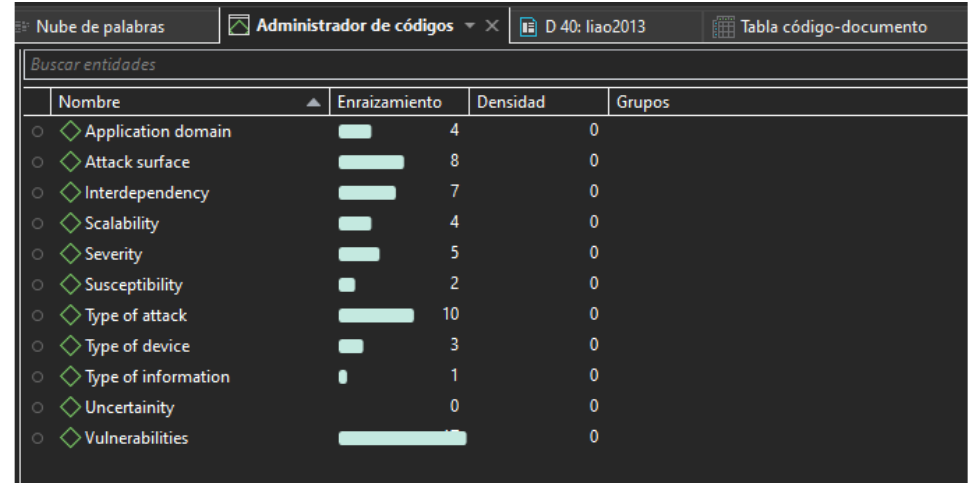
Figure 4. Density of the codes related with factors of IoT devices that could affect risk values.